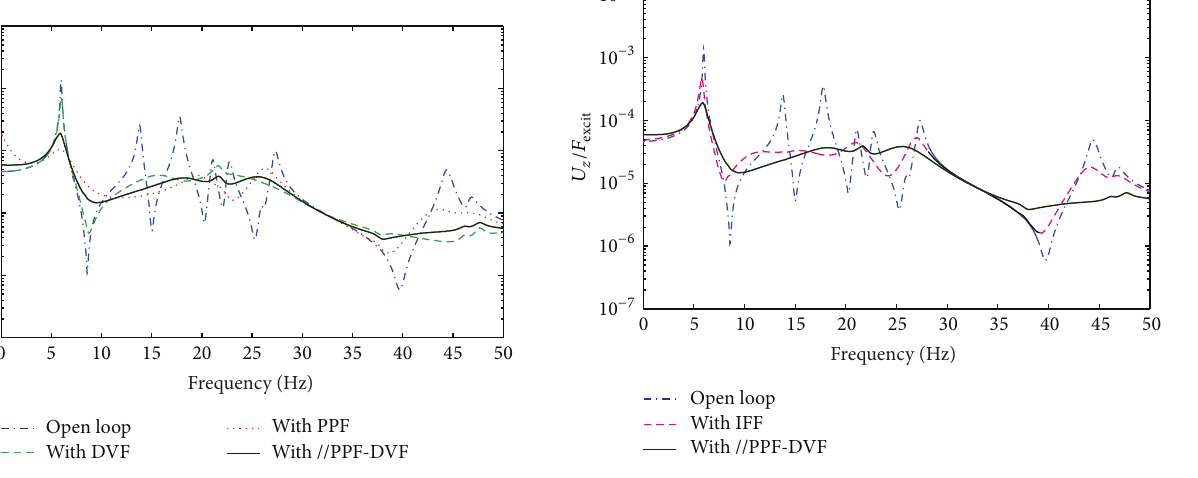
Figure 8: FRF between the force of excitation (Fexcit) and the vertical displacement of the deck ( 𝑈 𝑧 ) in point A for IFF and parallel PPF-DVF